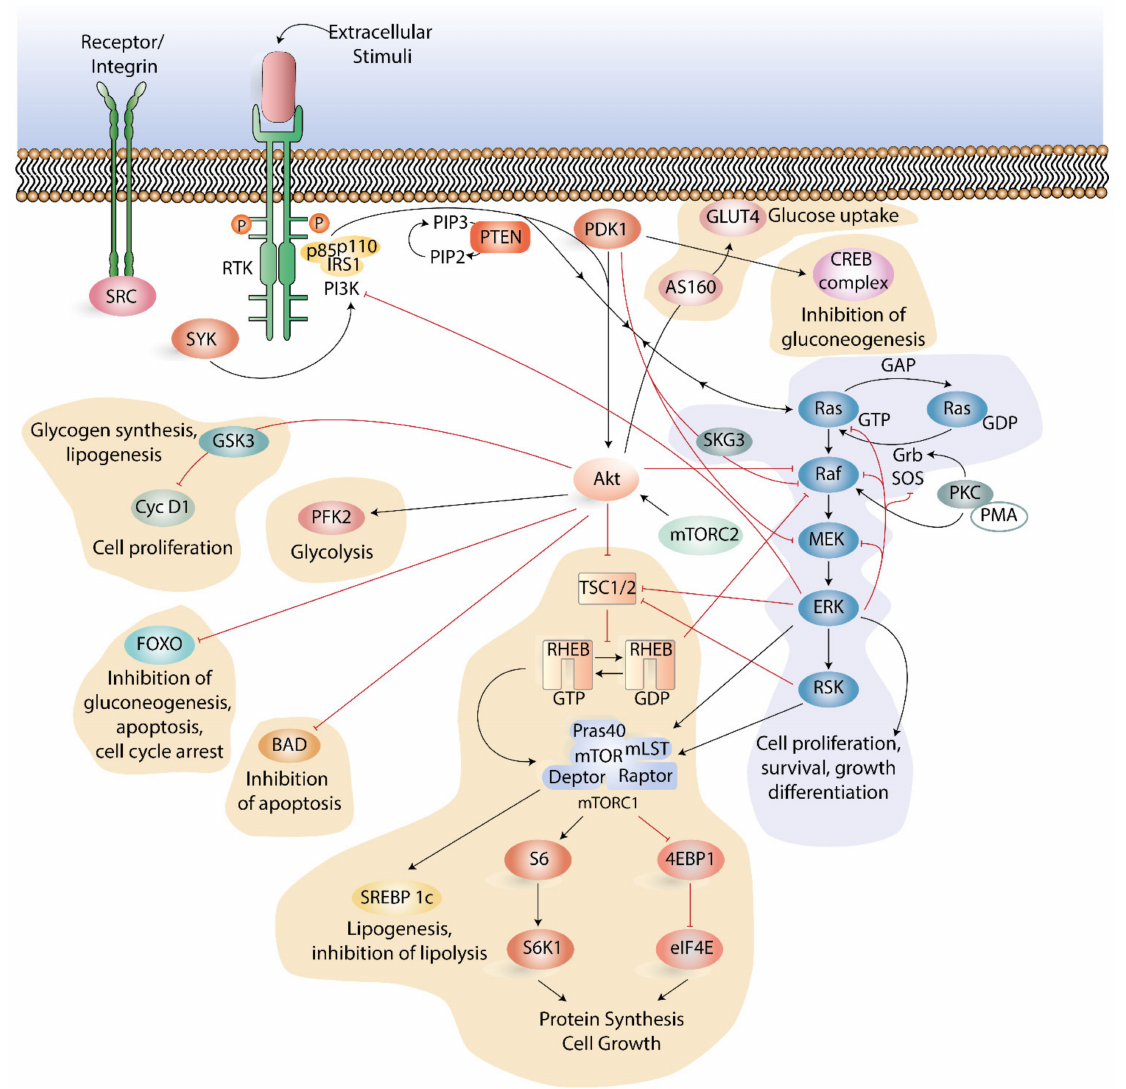
Figure 2. Main components and crosstalk between the Ras-Raf-mitogen-activated protein kinase-Ras- extracellular signal-regulated kinase (Ras-Raf-MEK-ERK) pathway, the spleen tyrosine kinase (SYK) pathway and the PI3K-Akt-mTOR pathway. All pathways respond to extracellular and intracellular signals to control cell survival, proliferation, motility, and metabolism, and are activated by the binding of a growth factor to a receptor tyrosine kinase (RTK) or integrins to receptors. In the Ras-MAPK pathway, this binding produces binding sites for the SHC and GRB2 adaptor molecules that recruit SOS to the membrane. SOS catalyzes the exchange of Ras GDP to Ras GTP, followed by the recruitment and activation of Raf. Protein kinase C (PKC) is directly bound and activated by phorbol 12-myristate 13-acetate (PMA) through its mimicking of the natural ligand of PKC. The mechanism by which PKC activates ERK remains unclear. Following a Ras activation of MEK, ERK is activated through an activation loop phosphorylation. The pathway is further regulated by a negative feedback loop from ERK. Pathway crosstalk is regulated through cross-inhibition and cross-activation between the components of the Ras-Raf-MEK-ERK and PI3K-Akt-mTOR pathways. Pathway crosstalk can also be regulated by binding of the p85 subunit of PI3K by phosphorylated SYK. When active, SYK increases the catalytic activity of PI3K, resulting in conversion of phosphatidylinositol 4,5-bisphosphate (PIP2) to PIP3. PI3K-Akt and Ras-Raf-MEK-ERK signaling networks exhibit examples of crosstalk